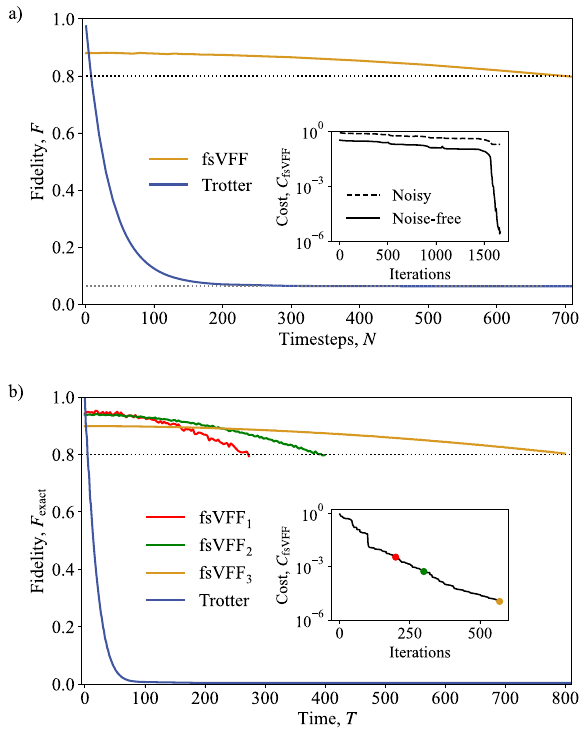
Fig. 4 Numerical Simulations. a Noisy Training and Fast-Forwarding of the 4 qubit XY Hamiltonian. The inset shows the cost curve as the ansatz is evolved and optimized to diagonalize the 4 qubit XY Hamiltonian in the 5-dimensional subspace spanned by initial state 1100 j i and its future evolution. The fi nal circuit found by the learning algorithm for the diagonalizing unitary, W , had 50 CNOT gates. The main plot evaluates the fast-forwarding performance of the trained ansatz, in comparison to the Iterated-Trotter evolved state. The fi delity is calculated against the ideal state found in simulation using the iterated Trotter method in the absence of noise, F ð N Þ ¼ ψ ð N Þh j ρ ψ ð N Þj i with ψ ð N Þj i ¼ U ð Δ t Þ N ψ 0 j i . The black dotted line highlights a threshold value F = 0.8. The gray dotted line at F = 1/2 4 represents the overlap with the maximally mixed state. b Training and Fast-Forwarding of the 8 qubit Hubbard Model. The inset shows the cost as it is iteratively minimized using an adaptive ansatz. Various quality diagonalizations are indicated by the colored circles. In the main fi gure, we plot the fi delity between the simulated state and the exact evolution as a function of time. The red, green and yellow lines denote fsVFF simulations using the corresponding quality diagonalization shown in the inset. In blue we plot the ψ ð T Þh j ρ ψ ð T Þj i fi delity of the Iterated-Trotter simulation, F exact ð T Þ ¼ trot with ψ ð T Þj i ¼ e (cid:2) iHT ψ 0 j i and ρ trot the simulated iterated Trotter